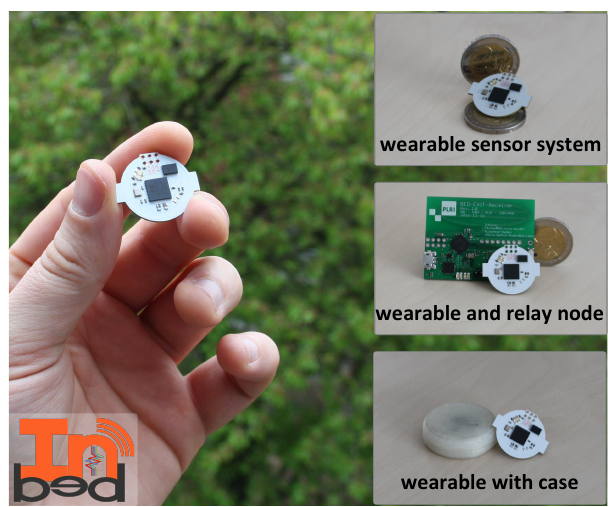
Figure 7. Current INBED wearable board with case and relay node.